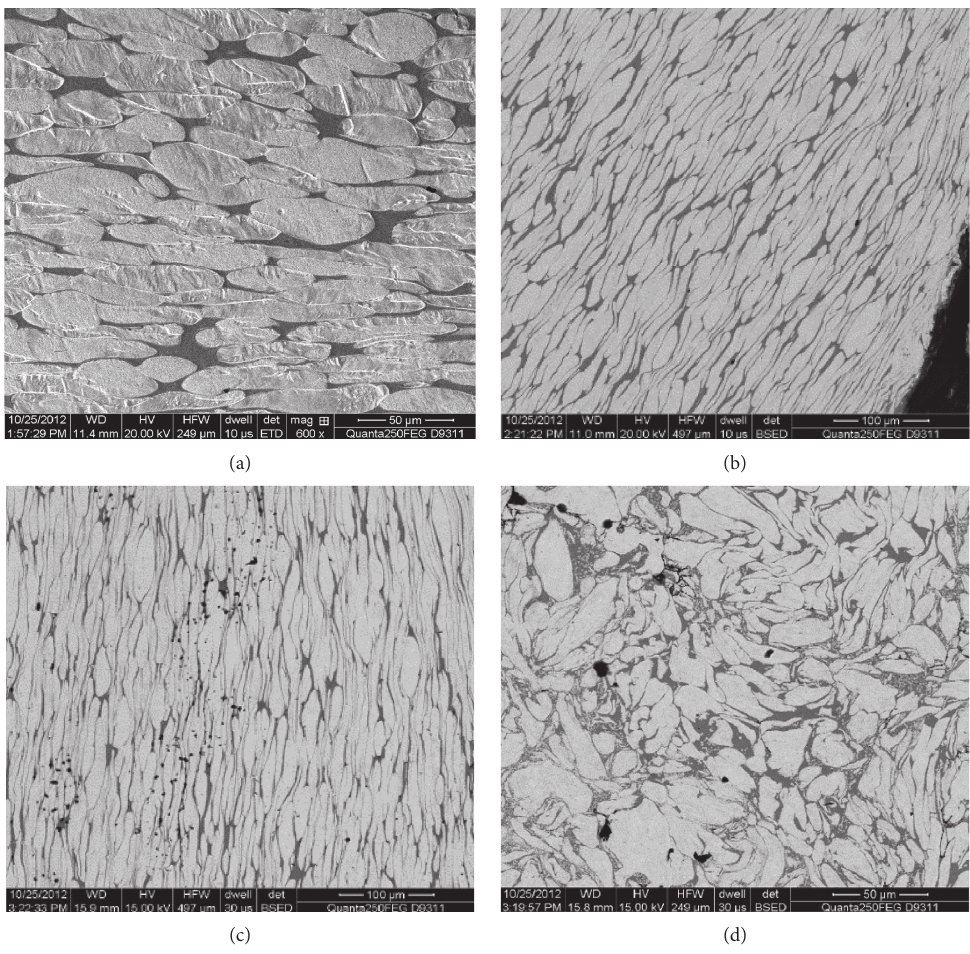
Figure 9: SEM photographs of the head of the residual projectile of 93W alloy in different positions of Figure 8: (a) in position A , (b) in position B , (c) in position C , and (d) in position D .